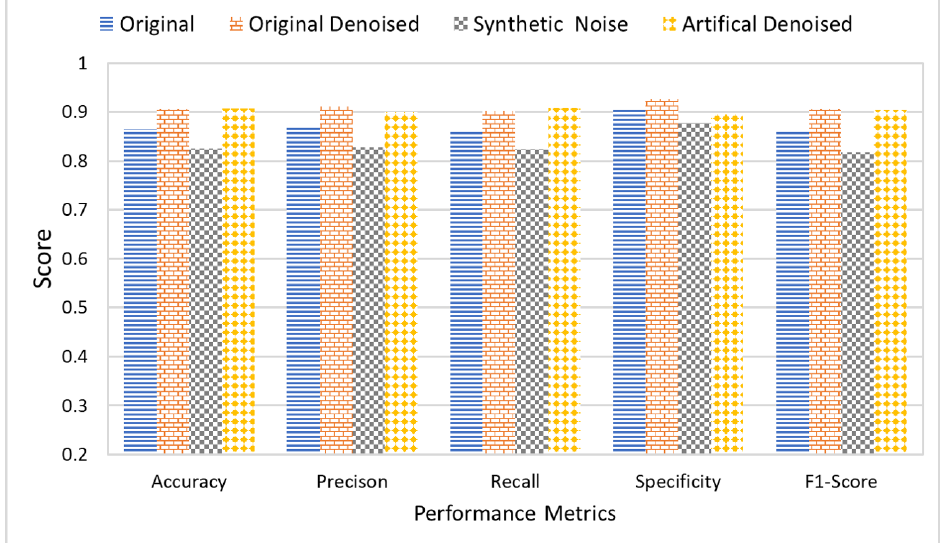
Figure 13. Comparative analysis of proposed and state-of-the-art DL techniques using noisy and denoised